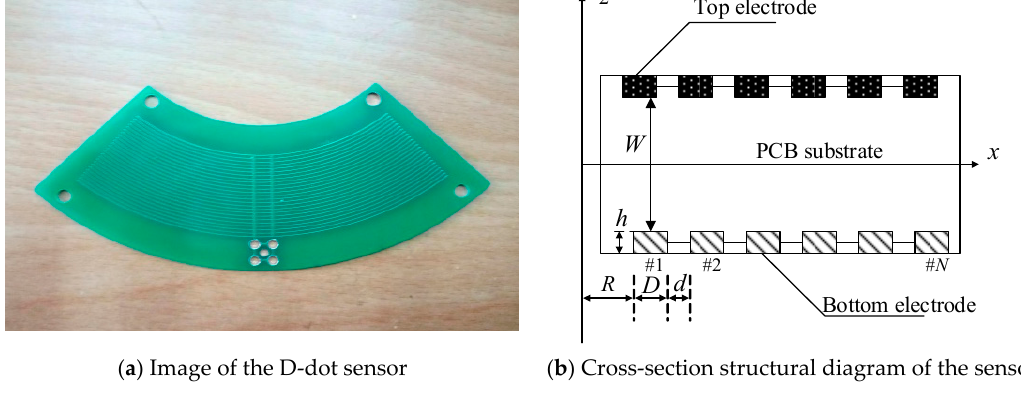
( b ) Cross-section structural diagram of the sensor Figure 1. D-dot electric field sensor. Figure 1. D-dot electric field sensor.